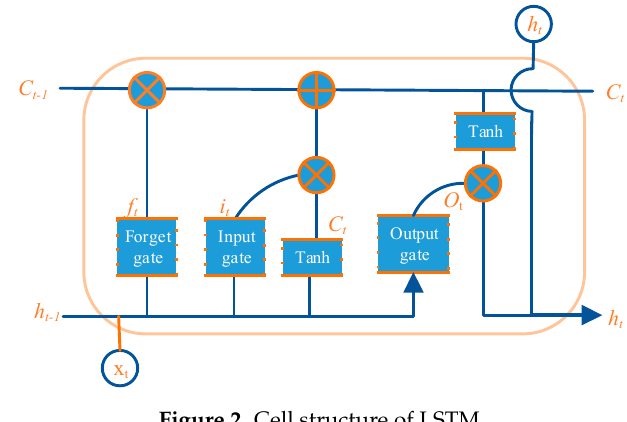
Figure 2. Cell structure of LSTM.